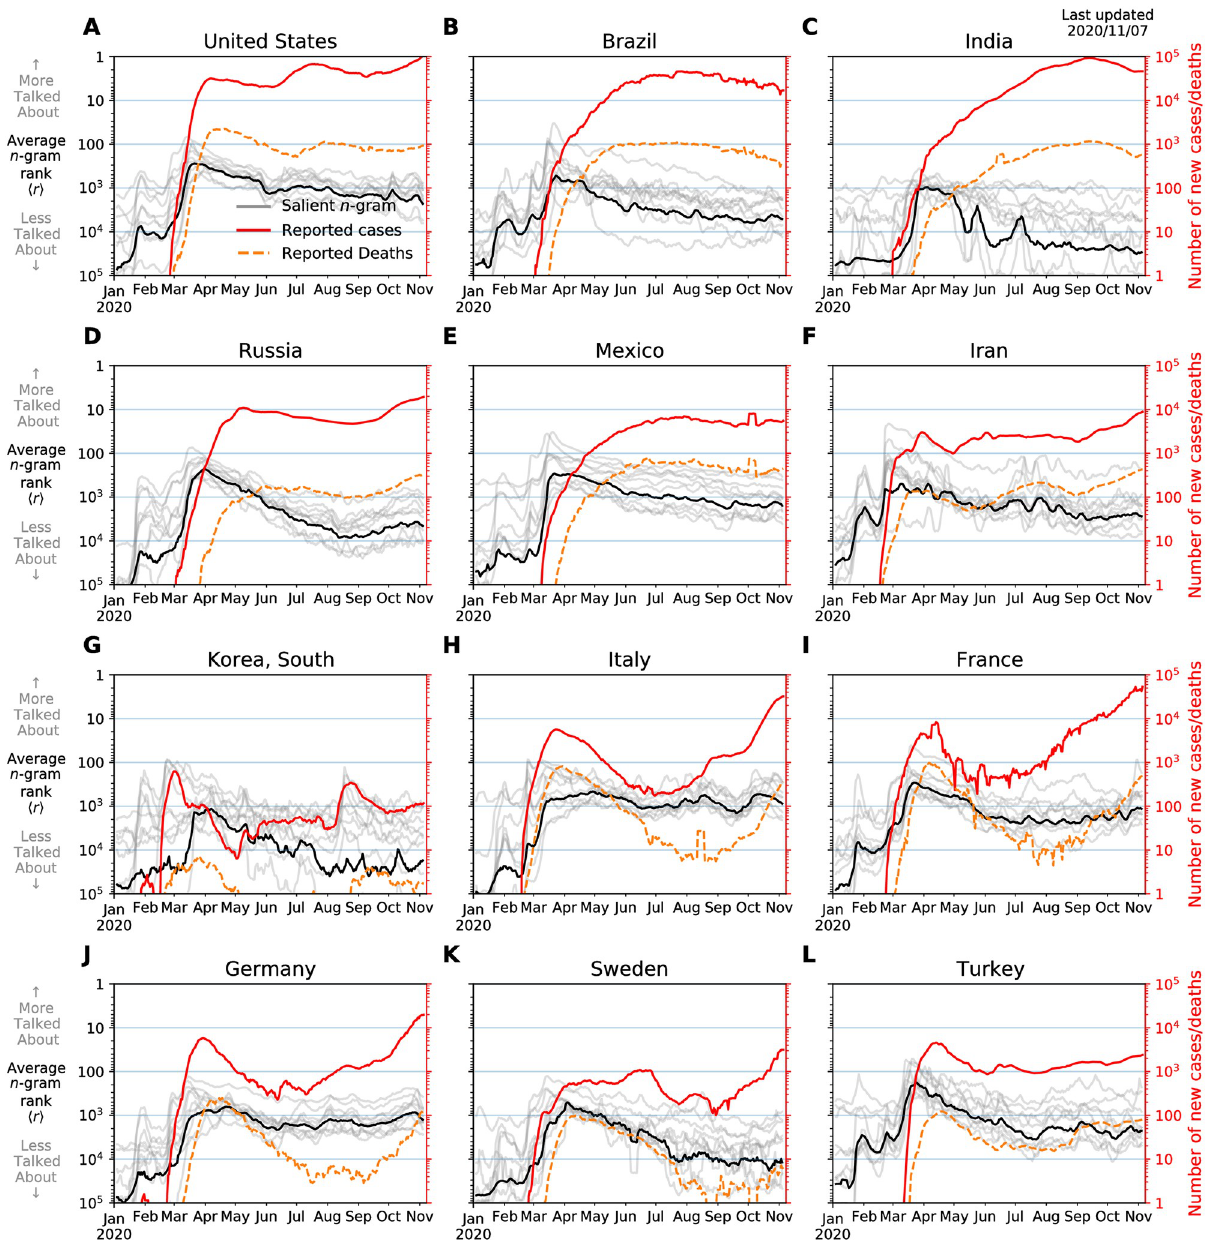
Fig 6. Time series for daily reported case loads and death compared with a list of 10 salient 1-grams for the top language spoken in each country. For each n -gram, we display a weekly rolling average of usage ranks at the day scale in gray overlaid by an average of all these 1-grams in black marking their corresponding ranks using the left vertical axis. Similarly, we use the right vertical axis to display a weekly rolling average of daily new cases (red solid-line), and reported new deaths (orange dashed-line). We note that the reported counts are underestimates, more so for cases than deaths, and errors are unknown. We sourced data for confirmed cases and fatalities from Johns Hopkins University Center for Systems Science and Engineering’s COVID-19 project [12]. Starting on 2020/01/22, the project’s data has been collected from national and regional health authorities across the world. The data is augmented by case reports from medical associations and social media posts—these later sources are validated against official records before publication. For the present piece, we use daily summary files for case counts and fatalities, although an API and online dashboard are available for more up-to-date